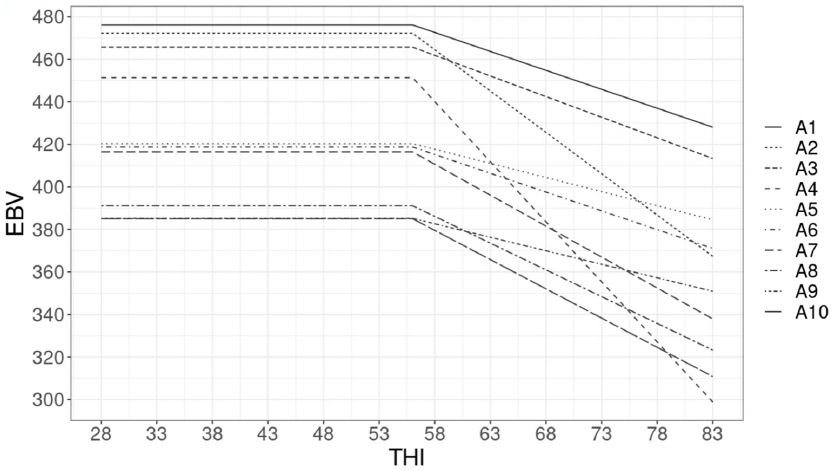
Figure 3. Top 10 bulls’ estimated breeding value (EBV) for fat yield as a function of the temperature- humidity index (THI).